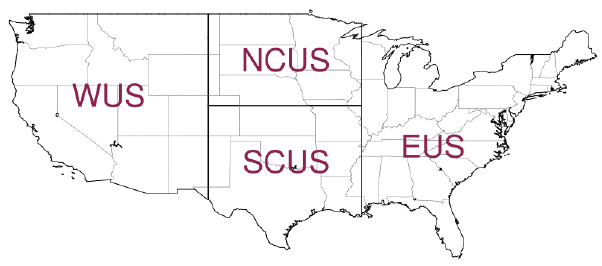
Figure 3. Geographic domain covered by each of the regions in- cluded in Figs.